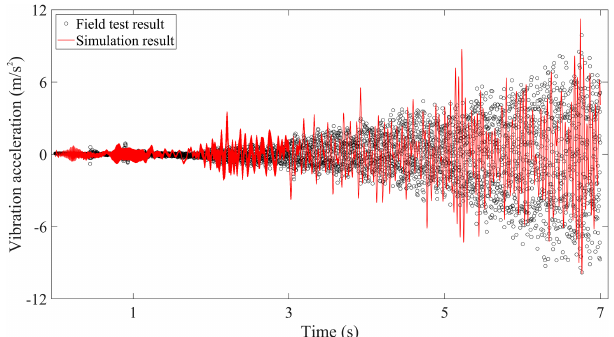
Figure 7. Comparison of vertical vibration responses of the traction motor.